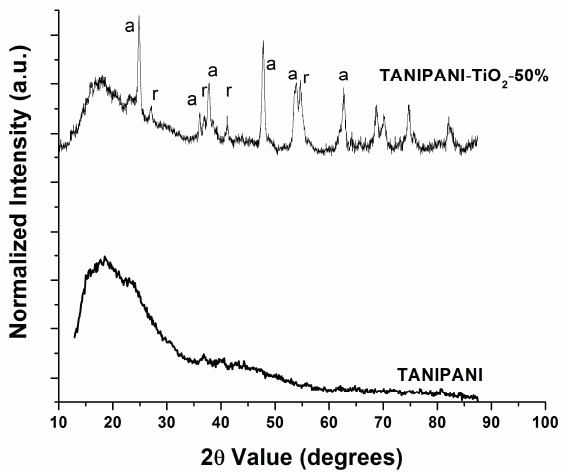
Figure 1. X-ray diffractograms of undoped TANIPANI-TiO 2 and TANIPANI